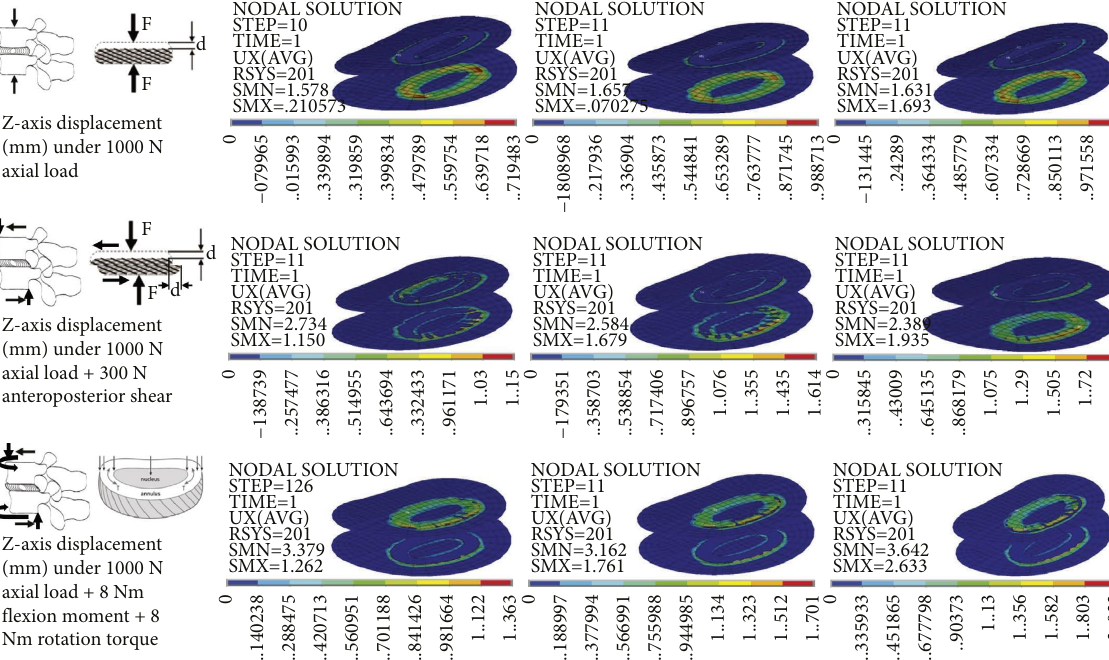
Figure 8: Contact pressure distribution on the vertebral endplates with the selected design nucleus replacement made of Bionate ® 80A, 90A, or 55D under 1000N axial compression